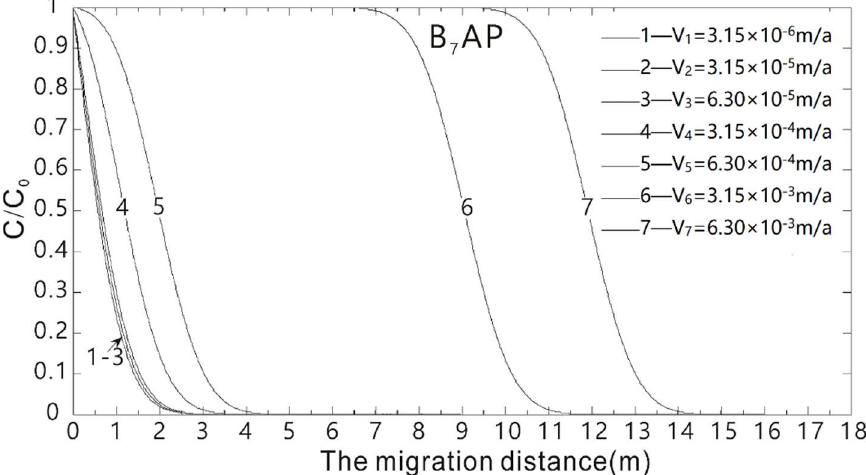
Figure 6. Effect of seepage velocity on migration of uranium in B 7 AP buffer material (t = 10 , 000 a) .